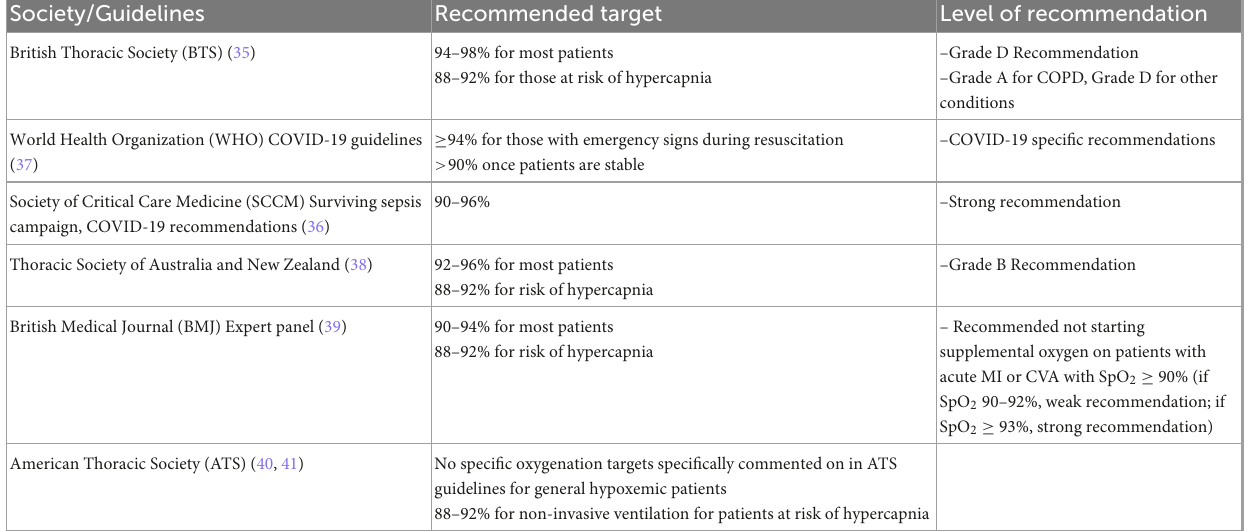
TABLE 2 Society guidelines for oxygen saturation